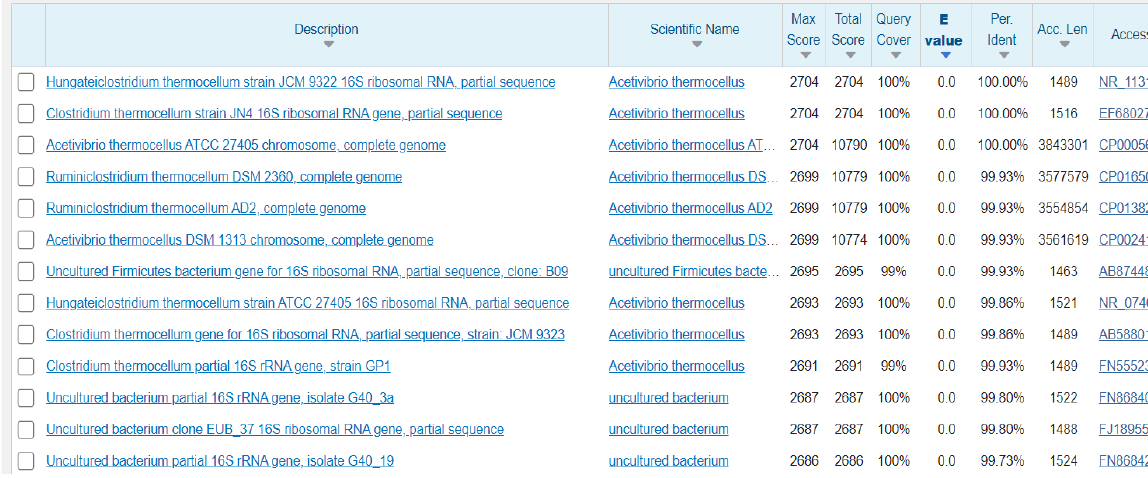
Table 3. Physiological and biochemical characteristics of FC811 strain.